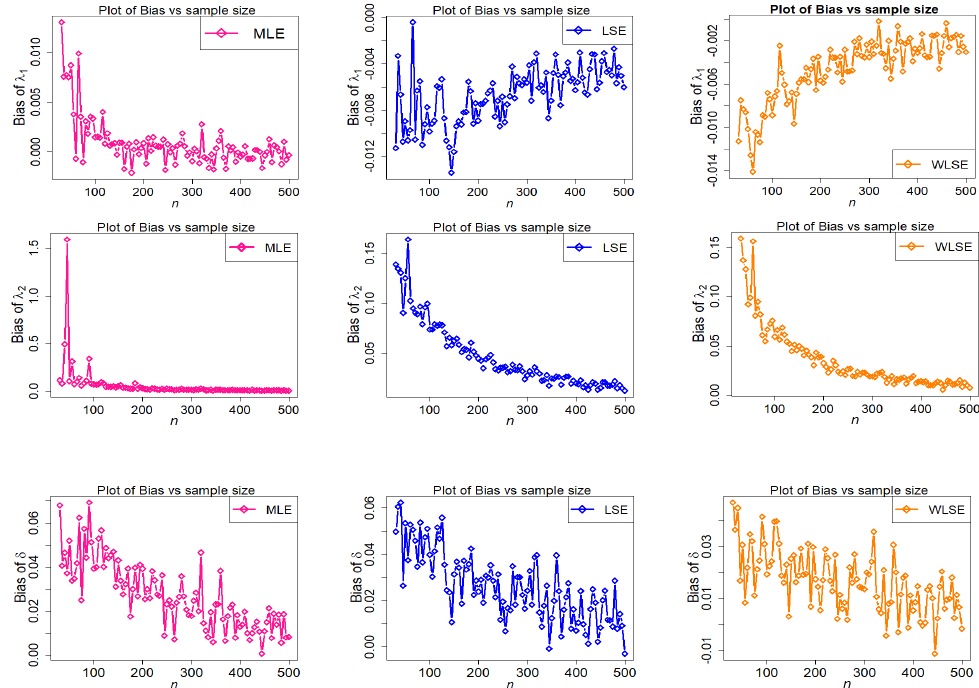
Figure 9. Behavior of bias of estimators with different methods under parametric set I against n Fig. 9. Behaviour of bias of estimators with di⁄erent methods under parametric set I against n .